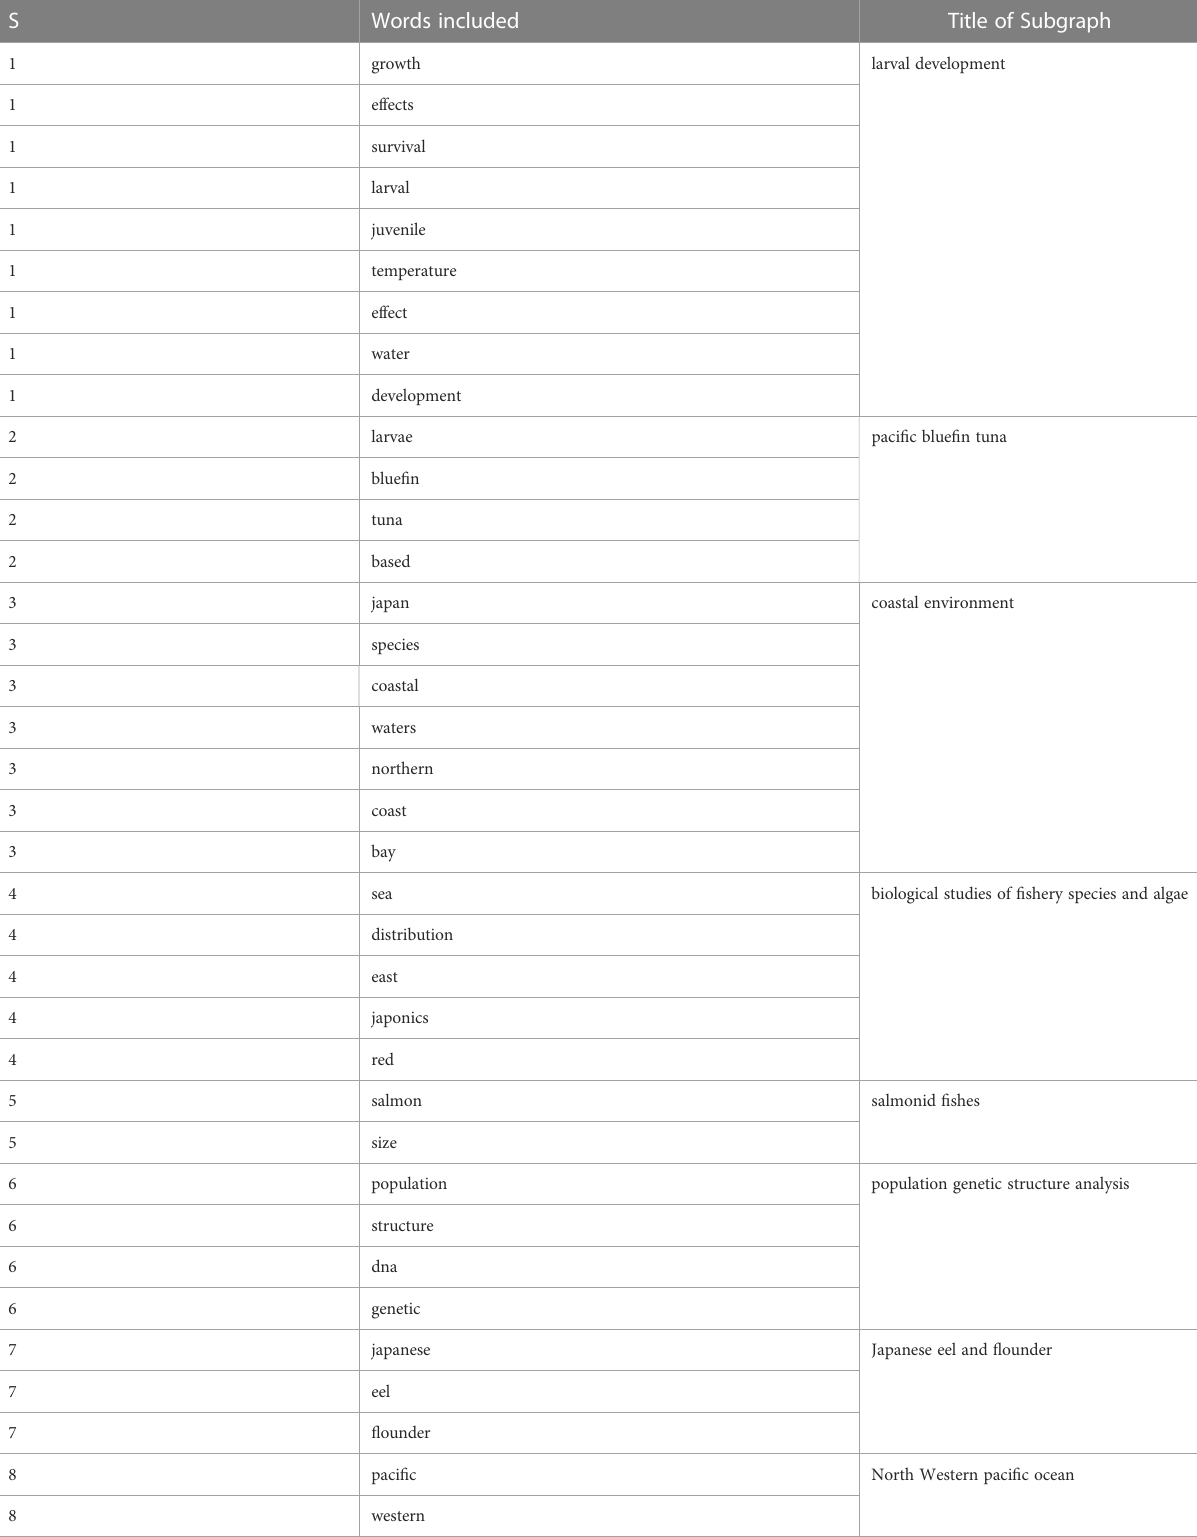
TABLE 1 Titled subgraphs and included words in the Co-occurrence network of the most frequent keywords among the published papers by JFRA researchers during 2004 and 2018 ( Figure 1